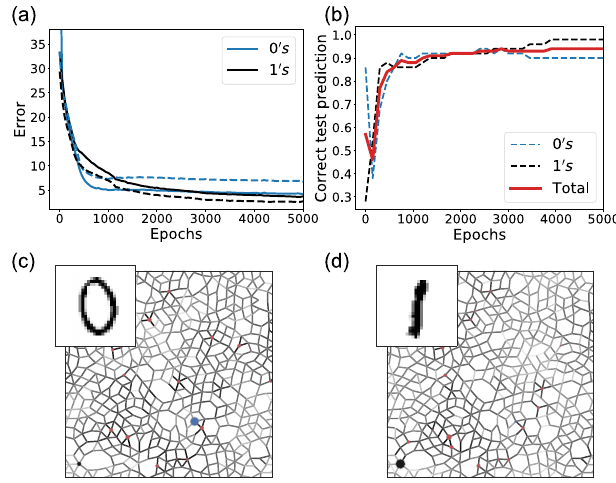
FIG. 4. Classification of MNIST digits (0 ’ s and 1 ’ s). (a) The classification error (value of cost function) [Eq. (11)] for the digits 0 (blue) and 1 (black) versus the number epochs, where each epoch consists of 100 iterations of the learning rule with a different randomly selected training image presented at each iteration. Training error is indicated by solid lines and test error by dashed lines. (b) Prediction accuracy on test images (fraction of correct predictions made by the network for digits 0 and 1) versus number of epochs. Total test accuracy shown in red. (c),(d) Response of the network when presented with the image at the top left. The power dissipated at each edge is indicated by the intensity of the edge color. while the pressures of target nodes are labeled with blue (0) and black (1) circles. When a 0 image is shown, the 0 target node has high pressure (blue circle) and the 1 target node has low pressure; when a 1 image is shown, the 1 target node has high pressure (black circle) and the 0 target node has low